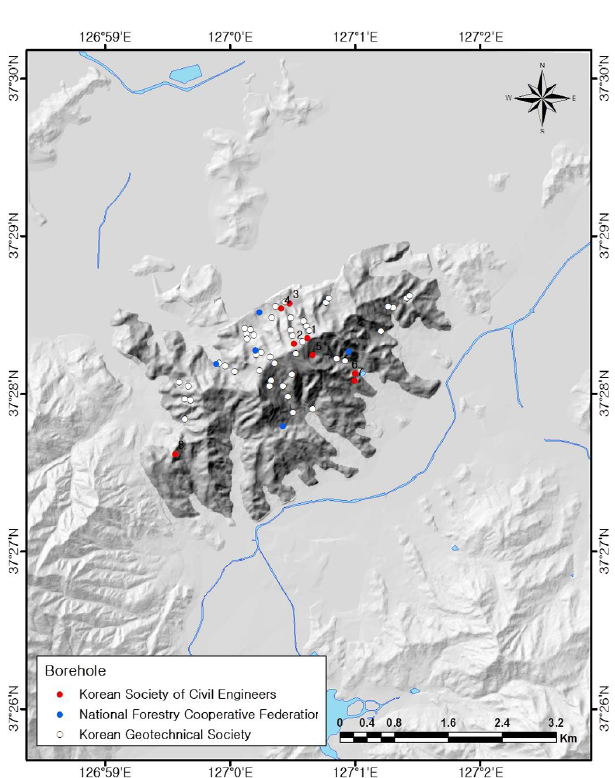
Fig. 9. Locations of investigation boreholes and sampling